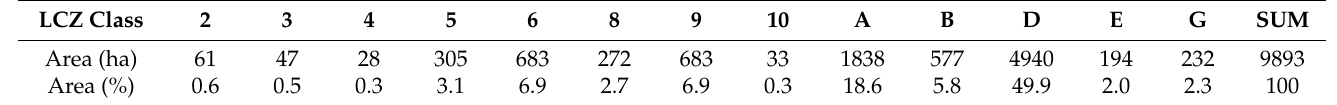
Figure 4. Delimiting local climate zones (LCZ) in Hradec Králové with marked AT measurement network—Section 2.3B (points numbered 1–7, when point number 1 indicates also location of field experiment described in Section 2.5). LCZ key: 2 compact mid-rise; 3 compact low-rise; 4 open high-rise; 5 open mid-rise; 6 open low-rise; 8 large low-rise; 9 sparsely built-up; 10 heavy industry; A dense trees; B scattered trees; D low plants; E bare rock or paved; G water. LCZs C and F do not either occur here or are represented only in a very limited amount, which does not allow objective analysis. Therefore, these were not included in the evaluation. Source: own processing based on classification algorithm [32]. Table 1. The total area of each LCZs in study area.